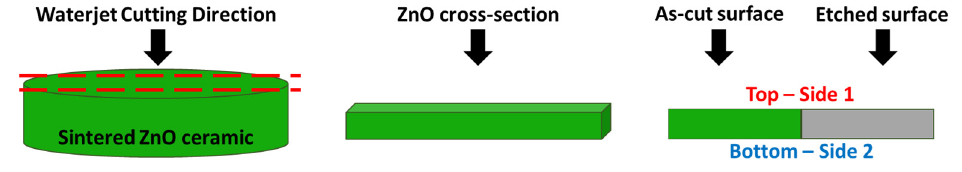
Figure 5. Abrasive waterjet cutting operation on ZnO varistors.